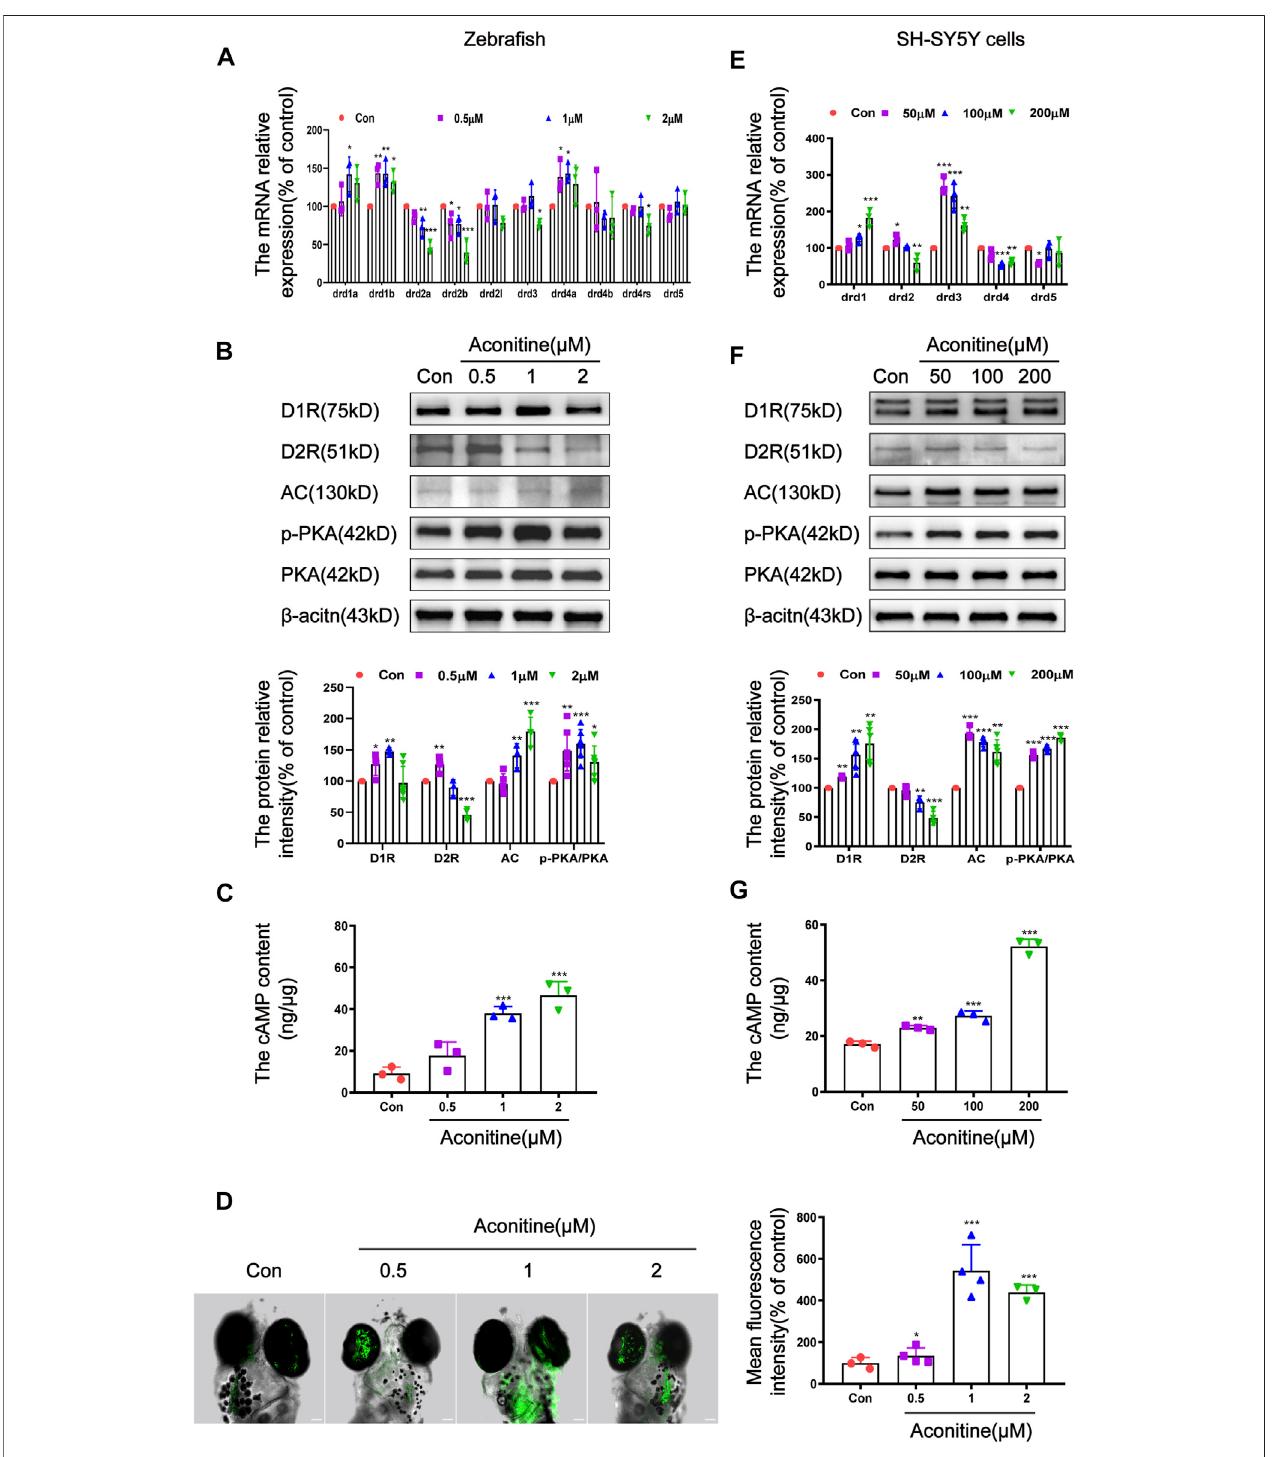
FIGURE 5 | Regulation of DR-mediated AC/cAMP/PKA signalling pathway by aconitine in zebra fi sh larvaes and SH-SY5Y cells. (A) Expression of DR mRNA with aconitineexposureinzebra fi shlarvaes, n =3. (B) D1R,D2R,AC,p-PKA, andPKAprotein expressionswithaconitineexposureinzebra fi shlarvaes, n =7. (C) ThecAMP contentswere examinedwithaconitine exposure by ELISAassaysin zebra fi sh larvaes, n =3. (D) ChangesofintracellularCa 2+ after treatment withaconitine inzebra fi sh larvaes, n =5. (E) Expression ofDR mRNA with aconitine exposurein SH-SY5Y cells, n = 5. (F) D1R, D2R, AC, p-PKA and PKA protein expressionswith aconitine exposureinSH-SY5Ycells, n =5. (G) ThecAMPcontentswereexaminedwithaconitineexposure byELISAassaysinSH-SY5Ycells, n =3.Allphotographsweretaken under a confocal microscope (100×). The values are expressed as mean ± SD. * p < 0.05, ** p < 0.01, *** p < 0.001 vs. control groups.